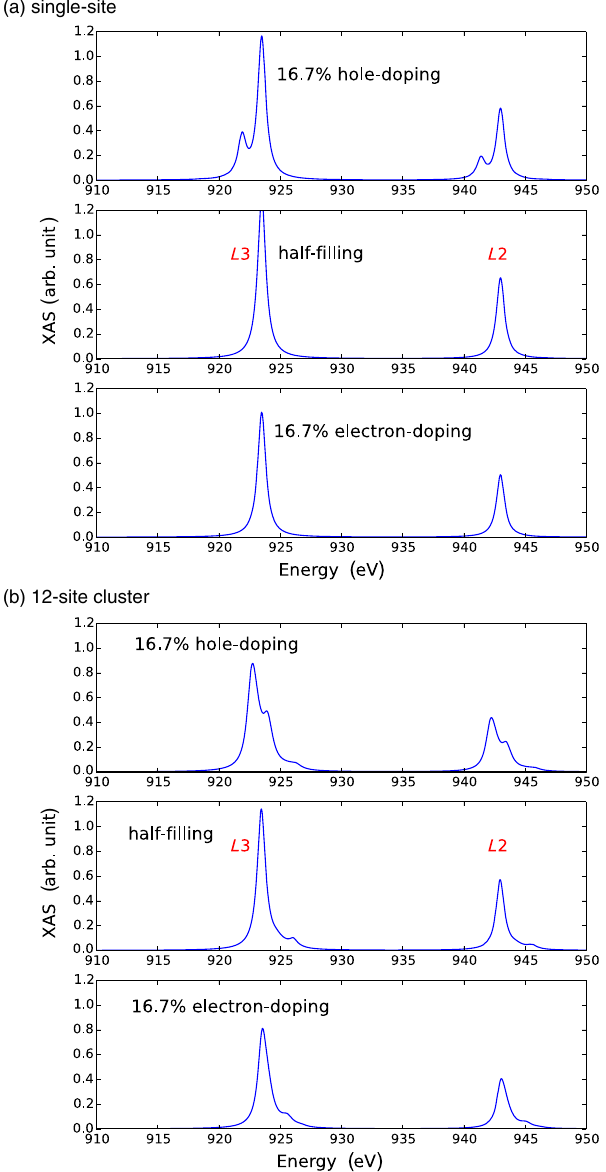
FIG. 7. Comparison between the Cu L -edge XAS spectrum calculated using exact diagonalization on a single site (top three panels) and on a 12-site cluster with both hopping t and t 0 taken into account in the Hubbard model (bottom three panels) for hole- doped, half-filling, and electron-doped cases (see text for more details). In this paper, RIXS is always calculated for the resonance corresponding to the XAS transition from the 2 p 0 3 d (cid:2) 1 to the 2 p 1 3 d (cid:2) 0 state and the L 3 edge (923 eV peak in the above